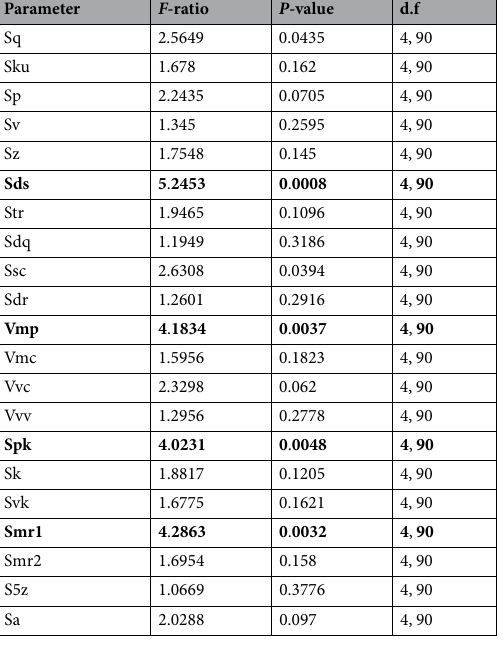
Table 2. ANOVA results (4 d.p) of ISO texture parameters between reptile dietary guilds. Data log transformed and scale limited using 5 th order polynomial and robust Gaussian filter. Texture parameters exhibiting significant differences after application of the Benjamini-Hochberg procedure shown in bold.